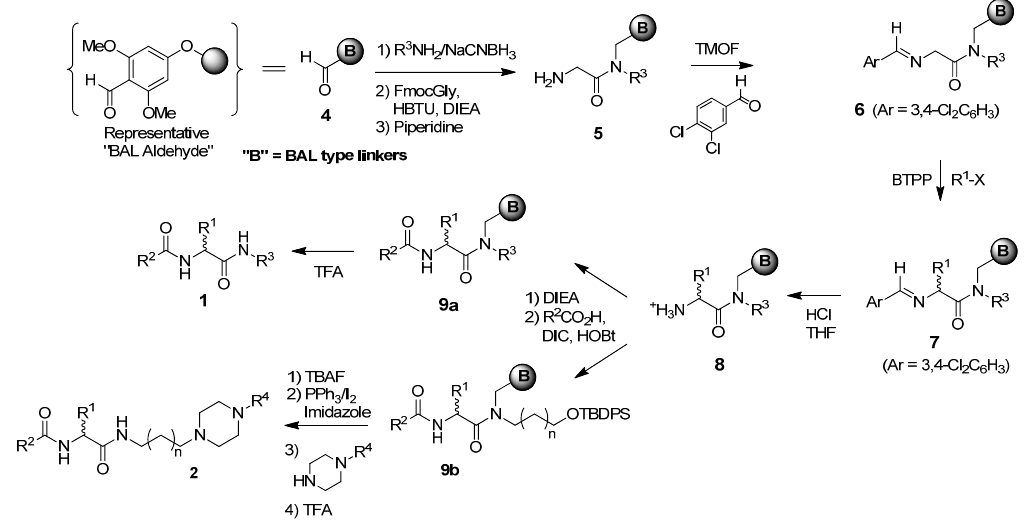
Figure 1. Fundamental peptide unit molecules 1 , 2 , and proline and proline homologues 3 .